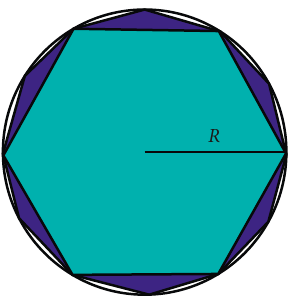
Figure 1: Liu Hui’s cyclotomic